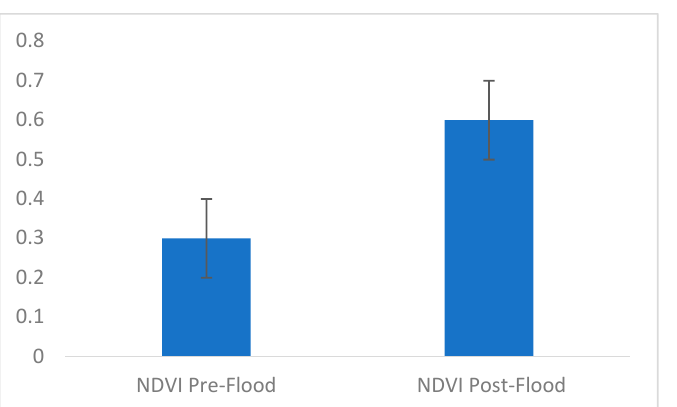
Figure 8. Mean pasture NDVI pre- and post-flooding. Error bars represented standard deviation (SD) of the mean.